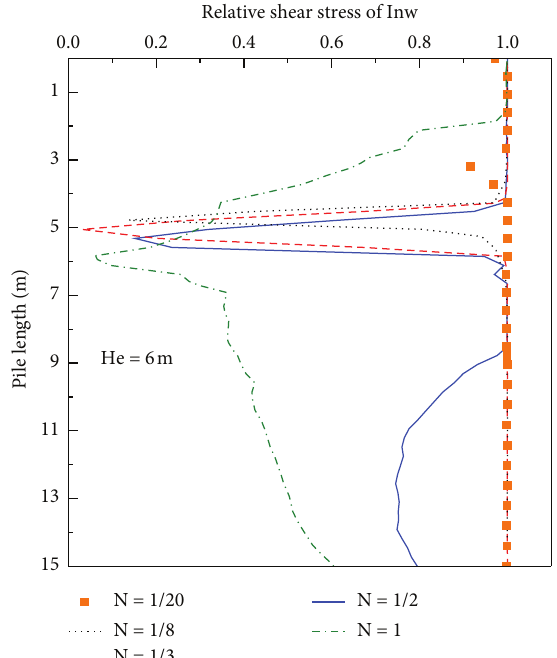
Figure 22: Comparison of the relative shear stresses of inward- inclined piles in VIIP with different N